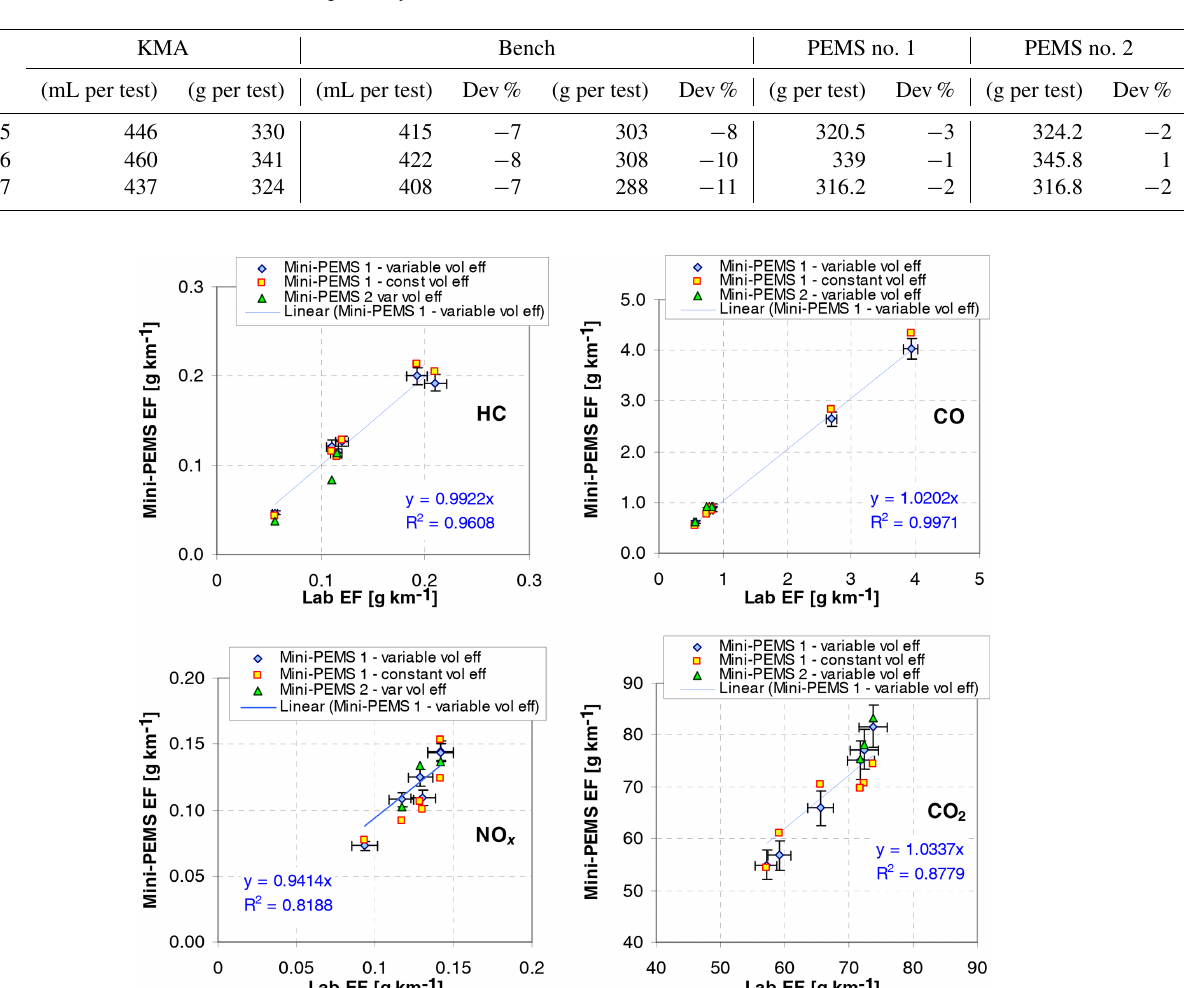
Table 5. Fuel consumption calculated from laboratory instrumentation (bench) and Mini-PEMS compared to the KMA fuel flowmeter (ref- erence). Volumetric and mass consumption from the bench were derived from Regulation EU 134/2014 (carbon balance, diluted emissions) and from instantaneous mass emissions, respectively.